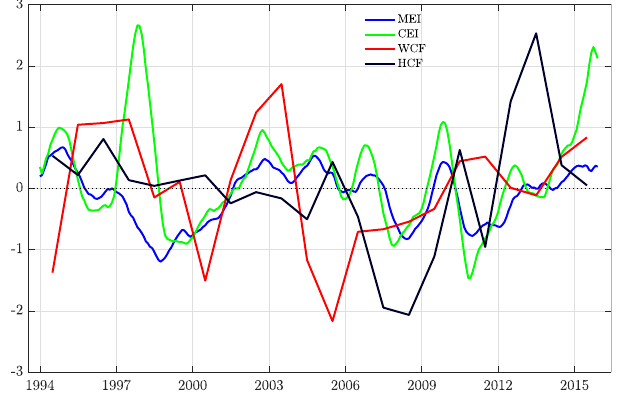
Figure 1. Capacity factors and ENSO indices: 12 point moving averaged canonical (CEI) and Modoki (MEI) ENSO indices and standardized capacity factors of wind (WCF) and hydropower (HCF). The unit along the y-axis is standard